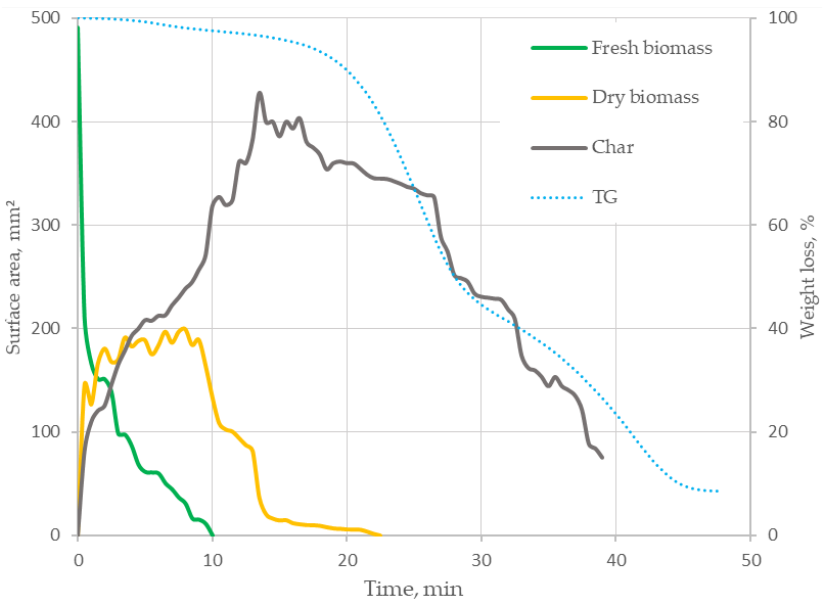
Figure 7. Change in the surface area of fresh biomass, dry biomass and char — sample 50K50J.